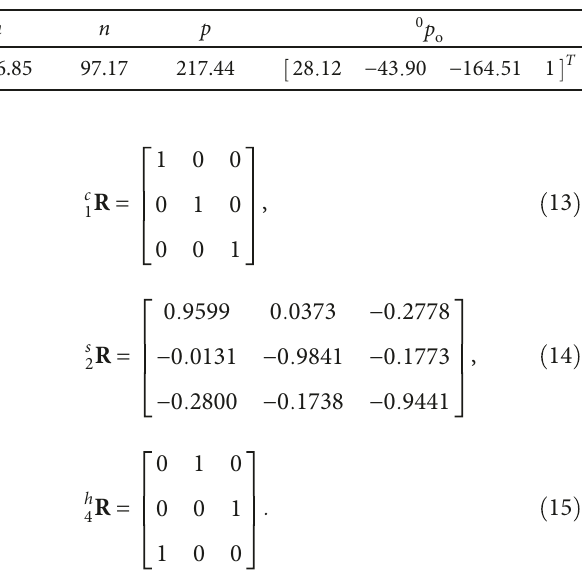
Table 2: The size parameters of thorax ellipsoid